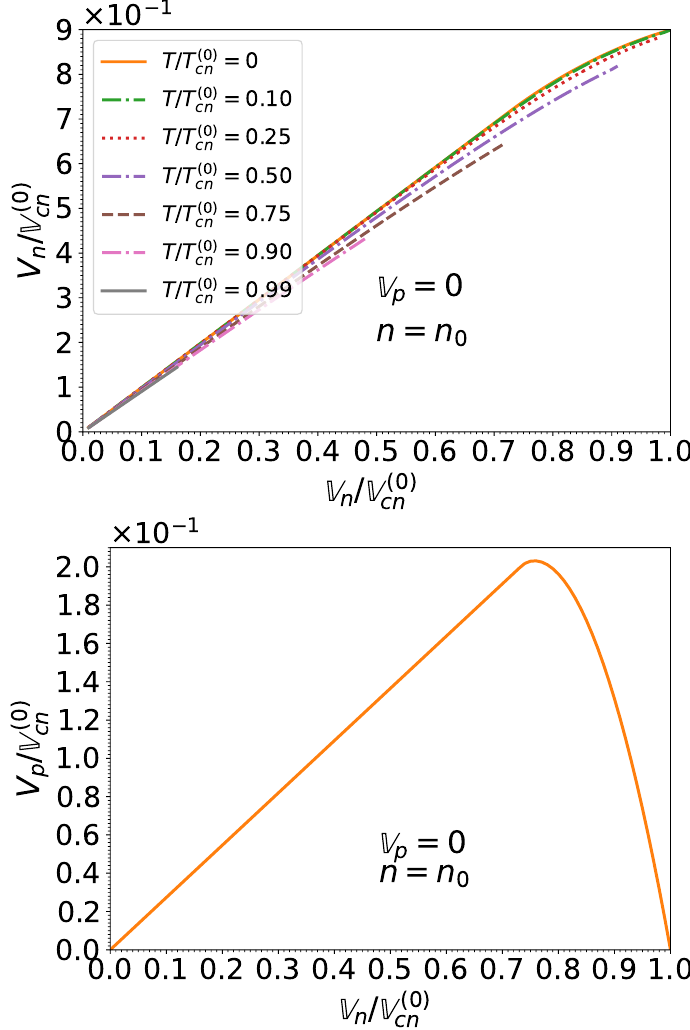
Figure 10. Same as Figure 9 at saturation density n 0 . Please note that for the proton superfluid ( 0 ) velocity V p , results for temperatures T ≤ T cp are all contained within the thickness of the solid